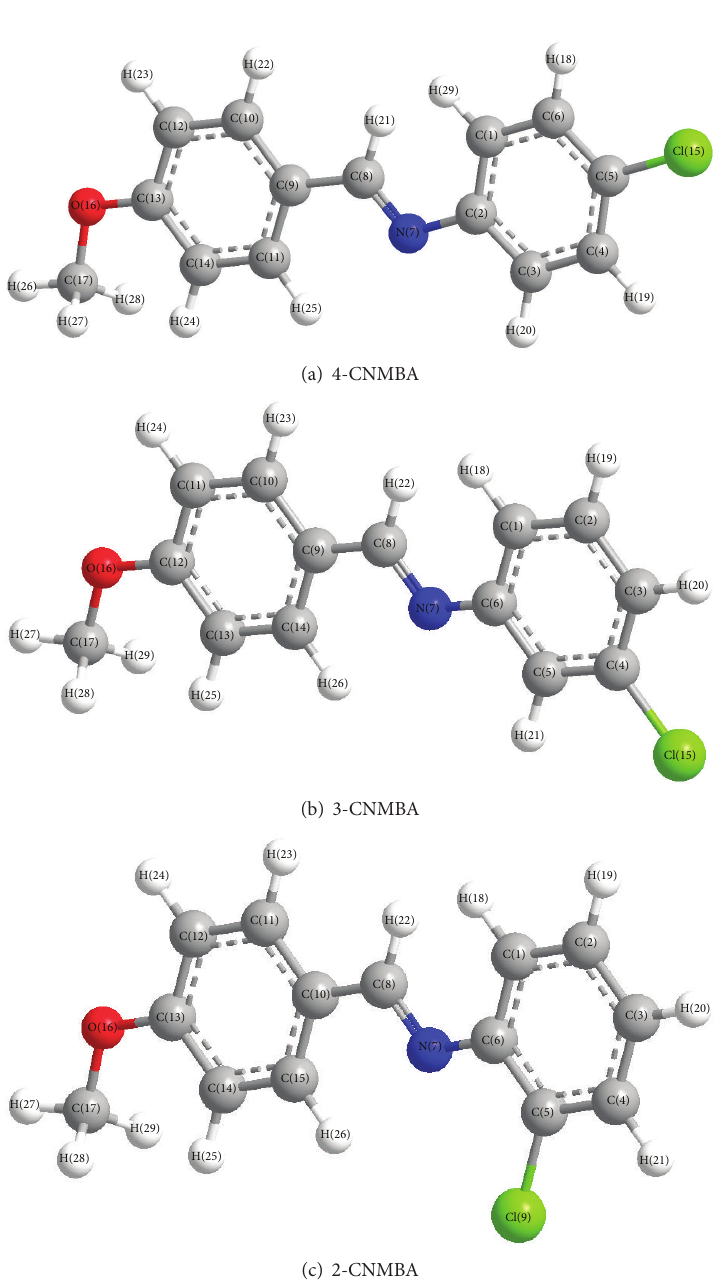
Figure 3: Optimized structures of the Schiff bases (a) 4-CNMBA, (b) 3-CNMBA, and (c)